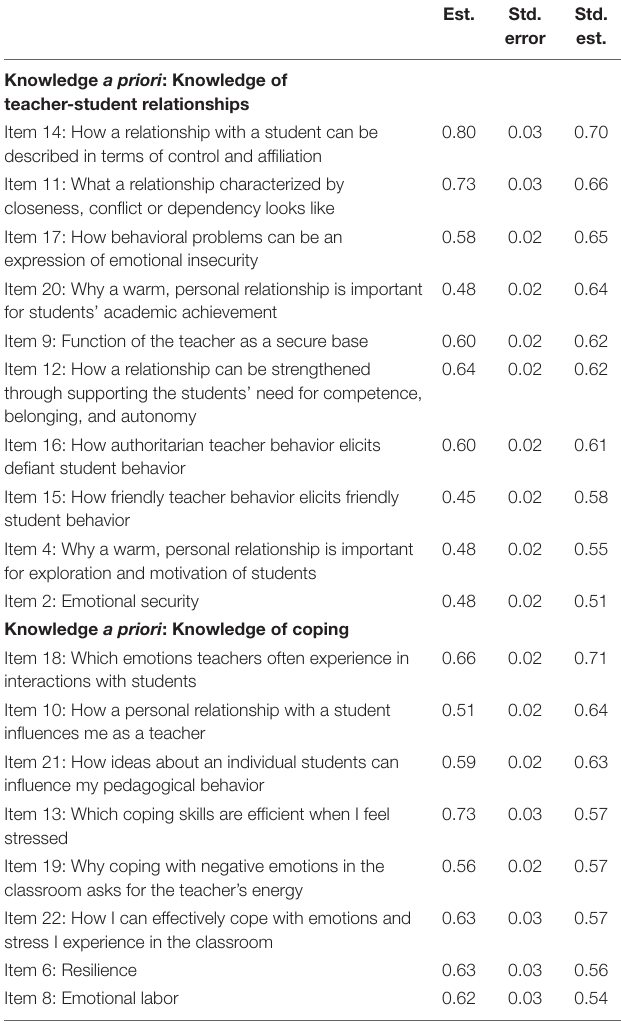
TABLE 7 | Results of confirmatory factor analysis for knowledge: final solution.